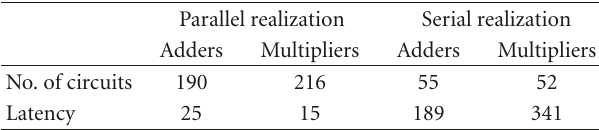
Table 5: Comparison between parallel and serial realization.